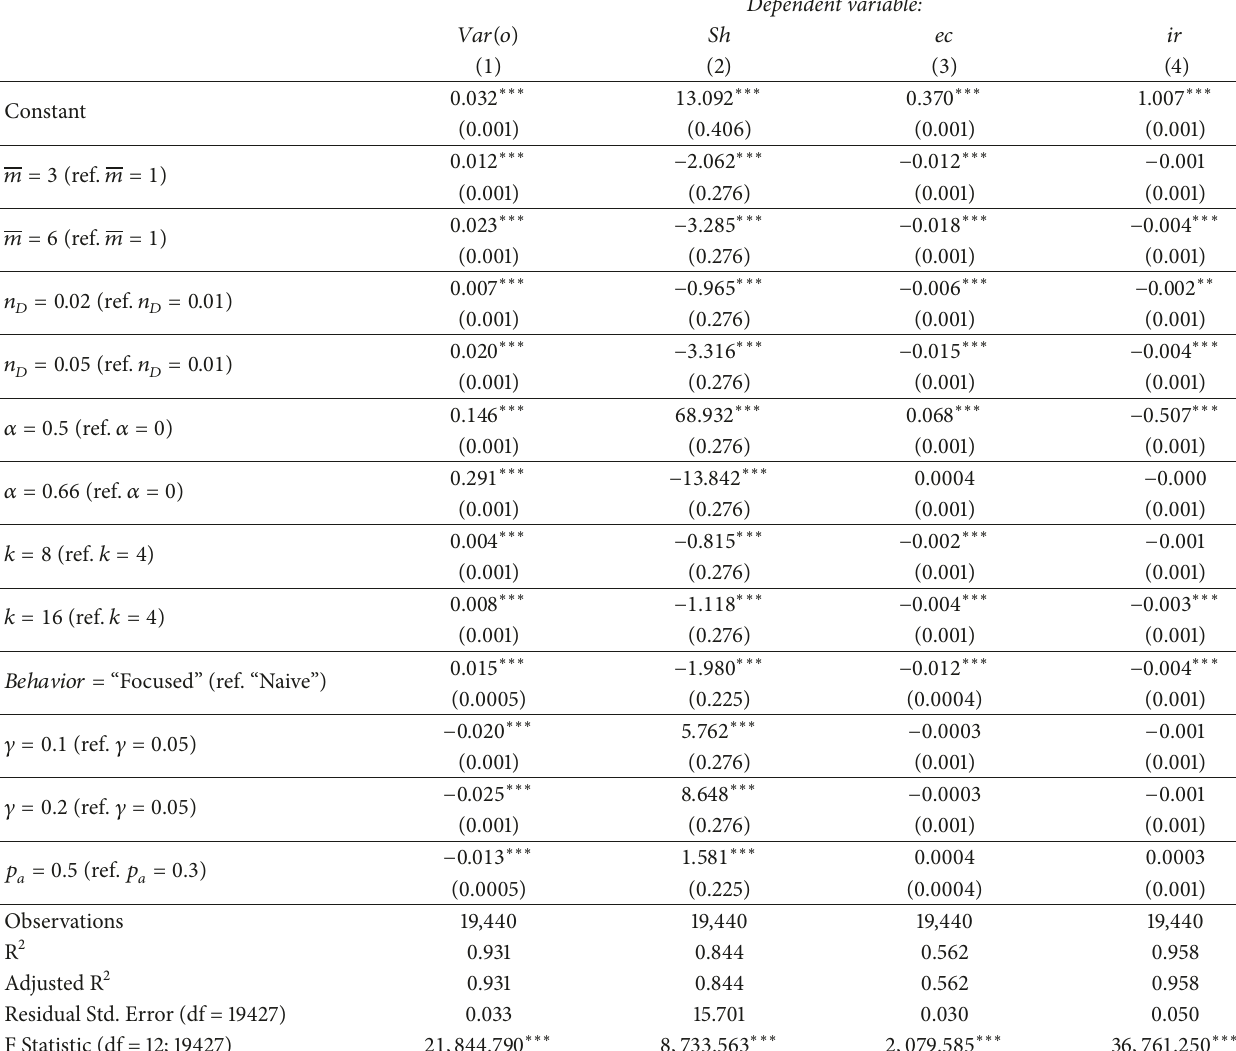
Table 4: Ordinary least squares estimates for the deliberative interactions scenarios for most of the observed